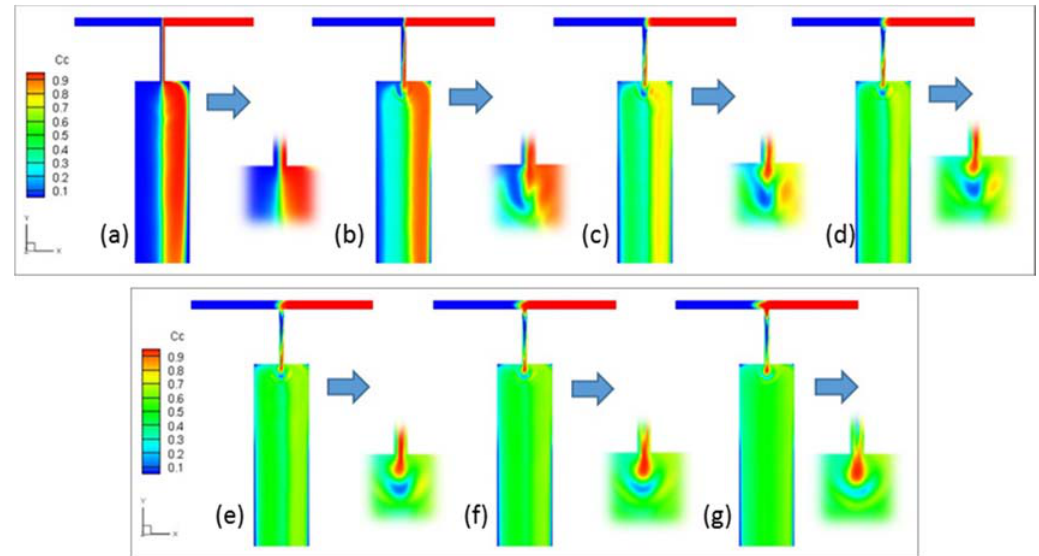
Figure 8. Concentration distribution in viscoelastic fluid case under modulated pressure at both inlets with phase difference ( a ) 0, ( b ) π /6, ( c ) π /3, ( d ) π /2, ( e ) 2 π /3, ( f ) 5 π /6, and ( g ) π .